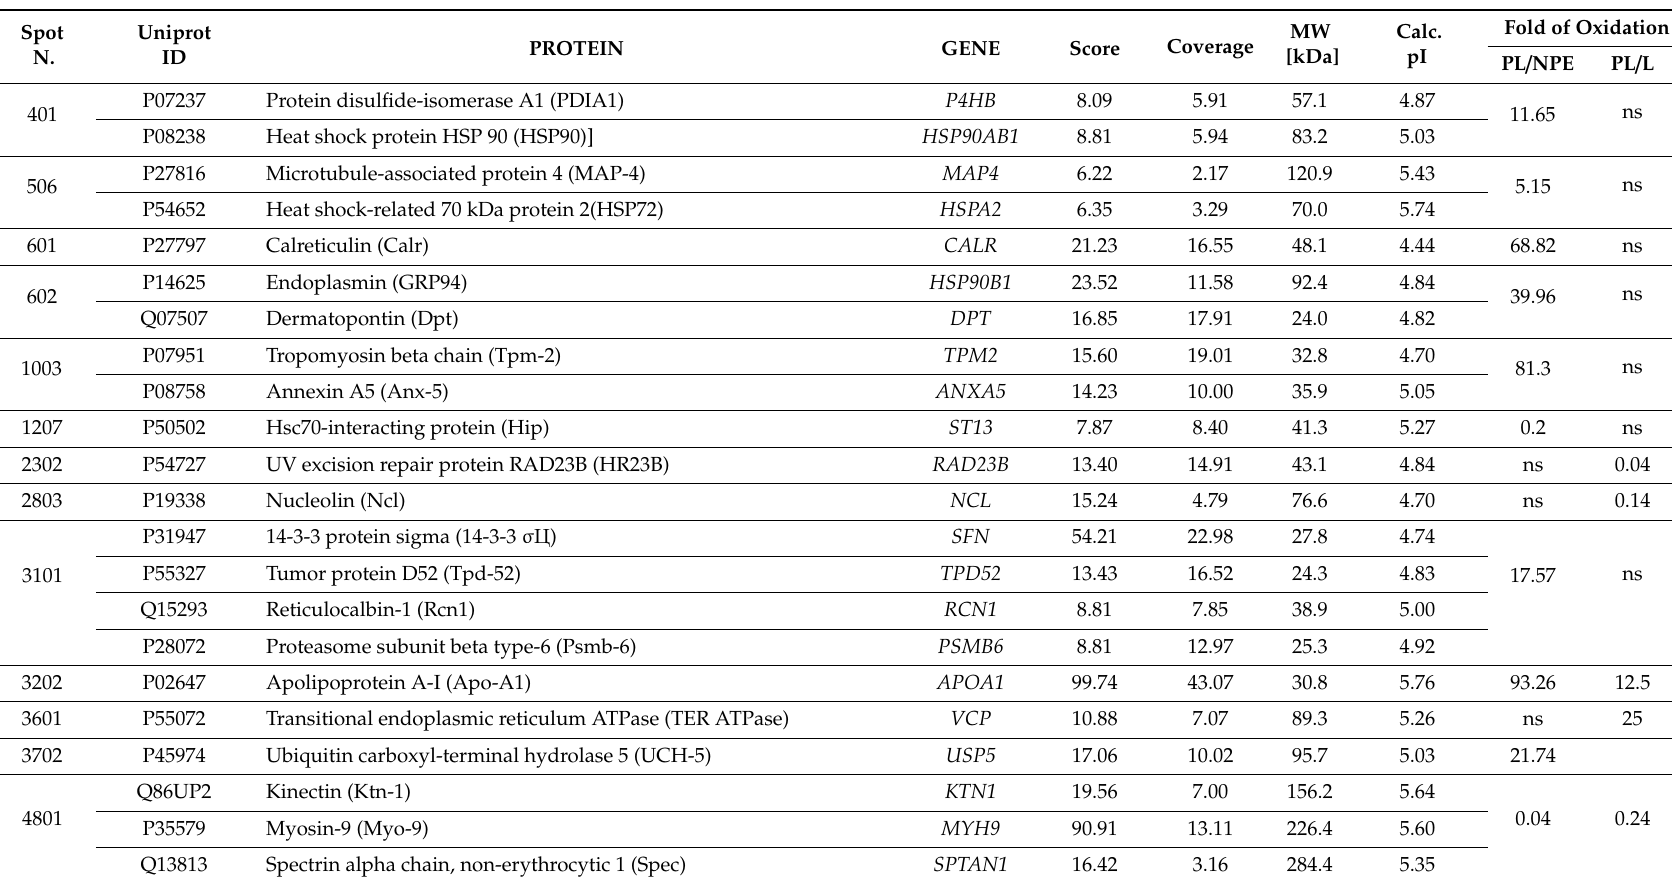
Table 2. Data from proteomics and mass spectrometry (MS) analysis. Each protein identified is characterized by the spot number on gel, the Uniprot ID number, the gene acronym, the identification score, the peptides coverage, the putative molecular weight (MW), the calculated isoelectric point (pI) and the fold of oxidation in the group of comparison (PL vs. NPE or PL vs. L). Spot